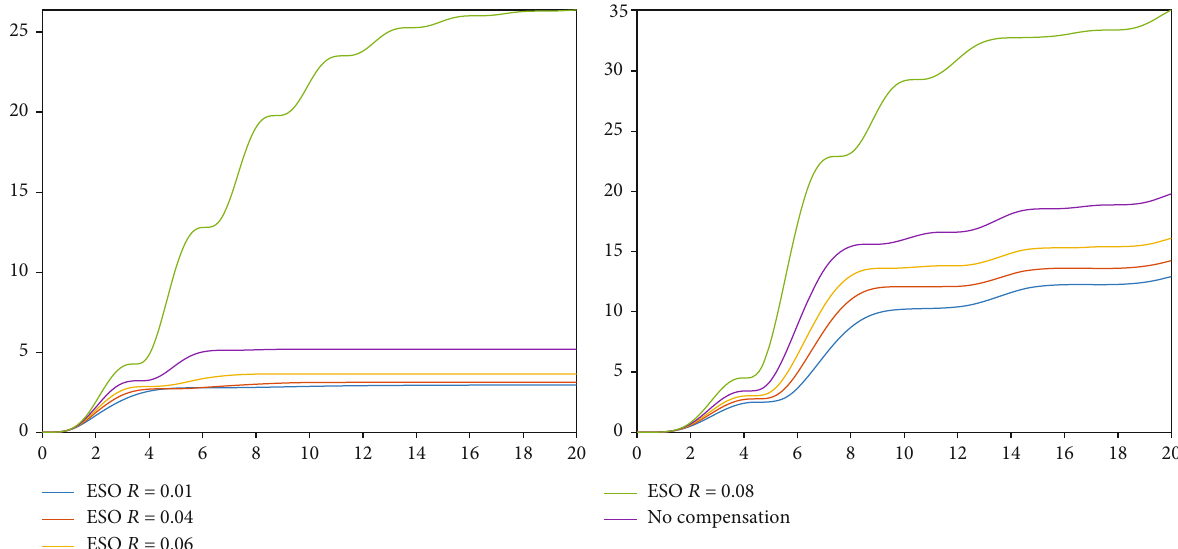
Figure 22: E ff ect of line-of-sight extraction on dimensionless miss distance under step and wave